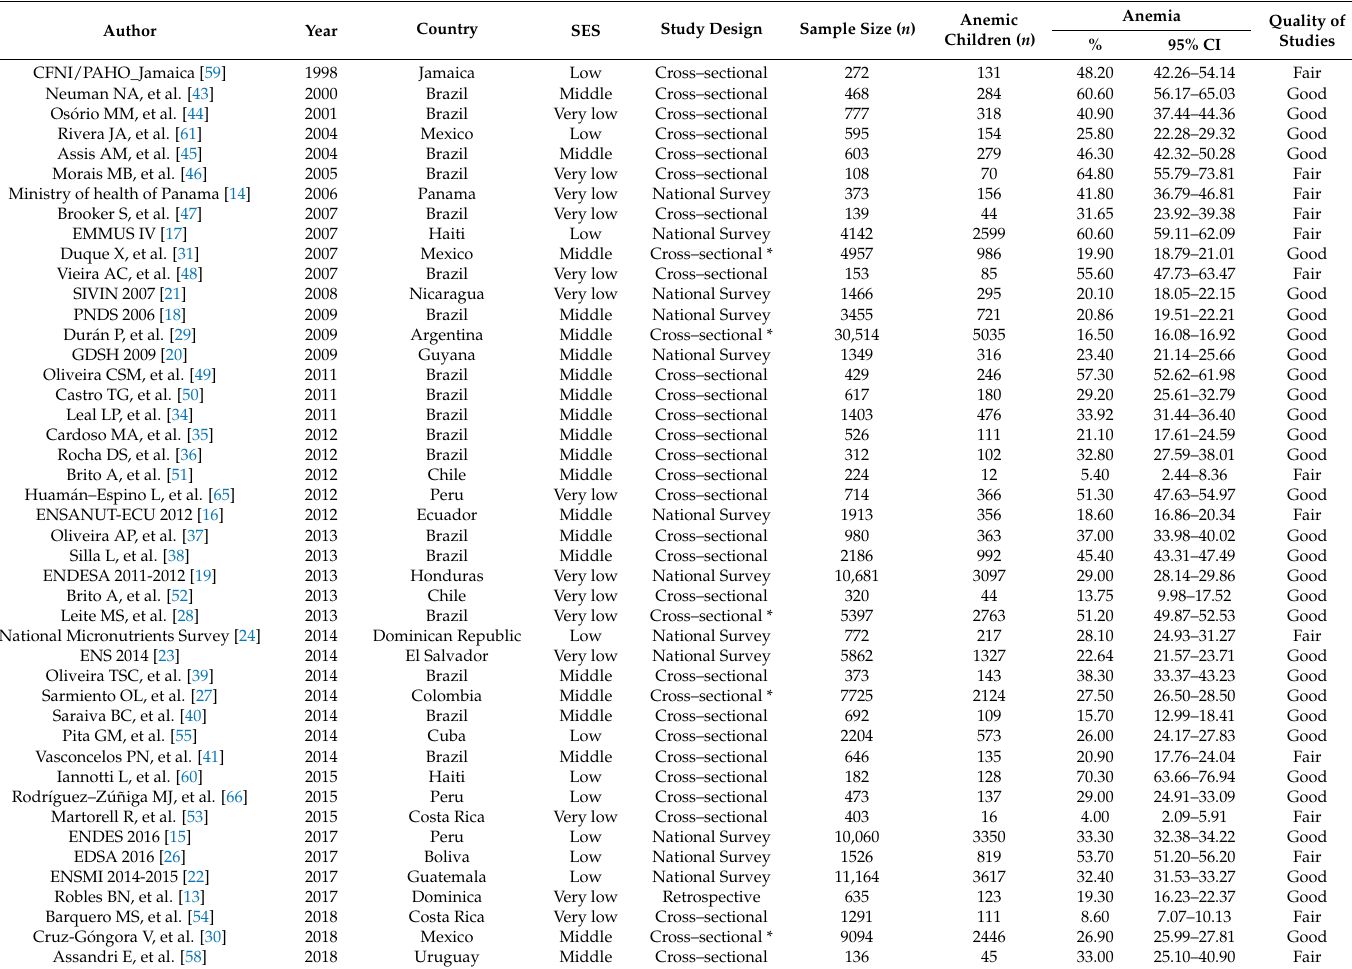
Table 1. Characteristics of studies that assessed preschool children (under 5